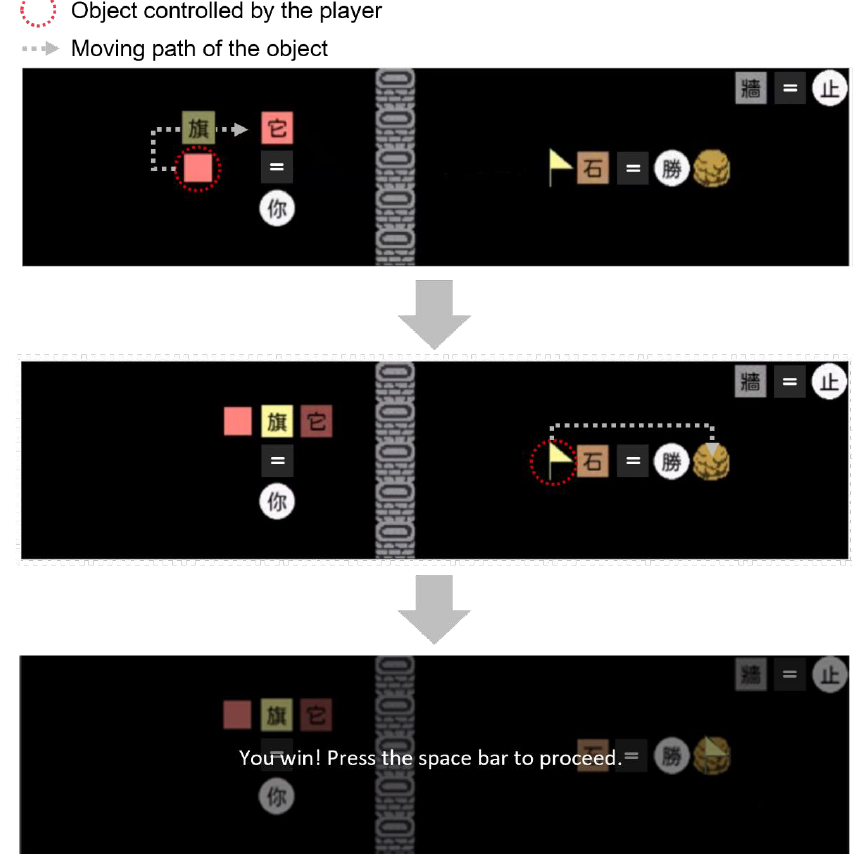
Figure 2. An example of a solution for the episode depicted in Figure 1. At first (top panel), a player moves the blank pink square to modify the equation made by the word tiles on the left side of the game field, resulting in changing the object controlled by the player (as depicted in the middle panel). Later, the player moves the flag to touch the stone to win the game (as depicted in the middle and the bottom panels). The red dotted circle indicates the object controlled by the player, and the white dotted arrow indicates the path along which the player moves the object; both are not shown in the game episode (see video: http://epa.psy.ntu.edu.tw/Liu_etal_2022_sensors_demo_video.mov accessed: 22 January 2022).